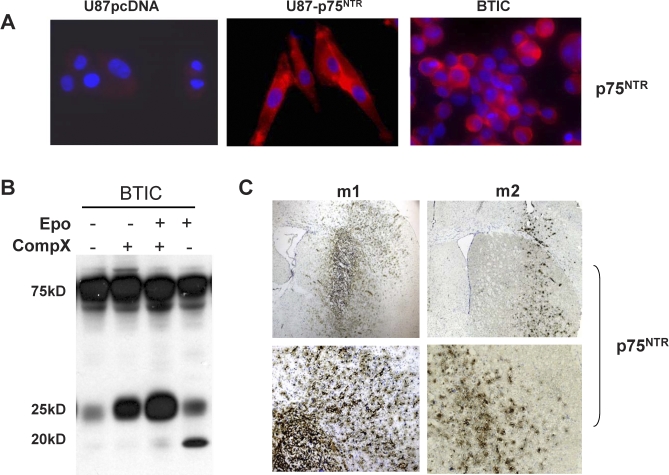
Regulated Intramembrane Proteolysis Occurs in Brain Tumor-Derived Stem-Like Cells (BTICs) from Glioma Patient Specimens(A and B) Primary cultures from human glioma patient tumor grown under brain tumor stem cell-promoting conditions (BTIC) express high levels of p75NTR (red) in vitro as detected by immunocytochemistry (A) and western blot (B). U87 cells stably expressing pcDNA and p75NTR were used as negative and positive controls, respectively. Cultures were counterstained with DAPI (blue) to visualize the cell nucleus. (B) p75NTR expressed on the BTICs undergoes RIP. BTICs were grown in the absence and presence of 2 μM γ-secretase and/or 1 μM epoxomicin. Western blot analysis detected full-length p75NTR, CTF, and ICD with the accumulation of the 24-kDa CTF in the presence of the γ-secretase inhibitor (CompX).(C) Brain tumor-initiating cells (BTIC) express p75NTR in vivo. BTIC cells were implanted into the brains of SCID mice and allowed to establish for 4–8 wk. Animals were sacrificed, and frozen sections were stained with anti-p75NTR (brown). Sections were counterstained with toluidine blue (blue). Tumors established from BTICs express high levels of p75NTR and form highly infiltrative tumors. M1 and M2 are individual mice.